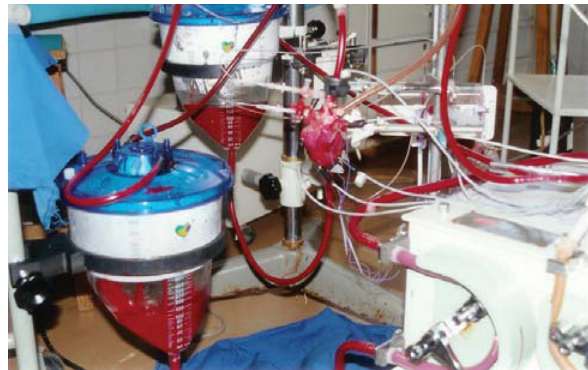
Fig. 2 - Visão geral do coração isolado perfundido. Coração isolado com minipinça metálica para indução da isquemia regional. Reservatório AE, funcionando como reservatório de pré-carga. Reservatório venoso de onde o sangue era reinfundido para o animal suporte. Linha